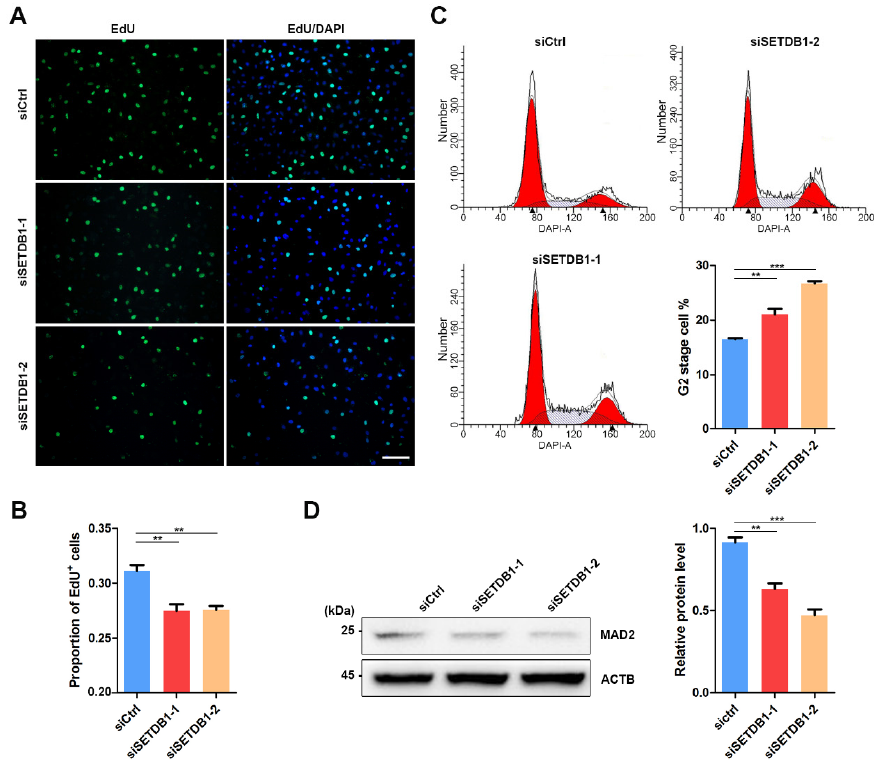
Figure 3. Knockdown of SETDB1 impaired cell proliferation and cell cycle transition. ( A ) Representative images of EdU incorporation in siSETDB1 and siCtrl cells. The proliferative cells were detected by Cell-Light EdU Apollo488 (green), and the nucleus was labelled with DAPI (blue). ( B ) Quantification of EdU incorporation in siSETDB1 and siCtrl cells. ( C ) Cell cycle analysis of siSETDB1 and siCtrl cells using flow cytometry. Proportion of the G2 stage cells is shown in the column diagram. The blank triangle indicates the peak of the Y-axis. ( D ) Western blot analysis of the protein levels of MAD2 and ACTB in porcine SSCs. The protein level of SETDB1 relative to ACTB is shown in the column diagram. Significance was presented as ** p < 0.01 or *** p < 0.001. Error bars represented the standard error of the mean (SEM).